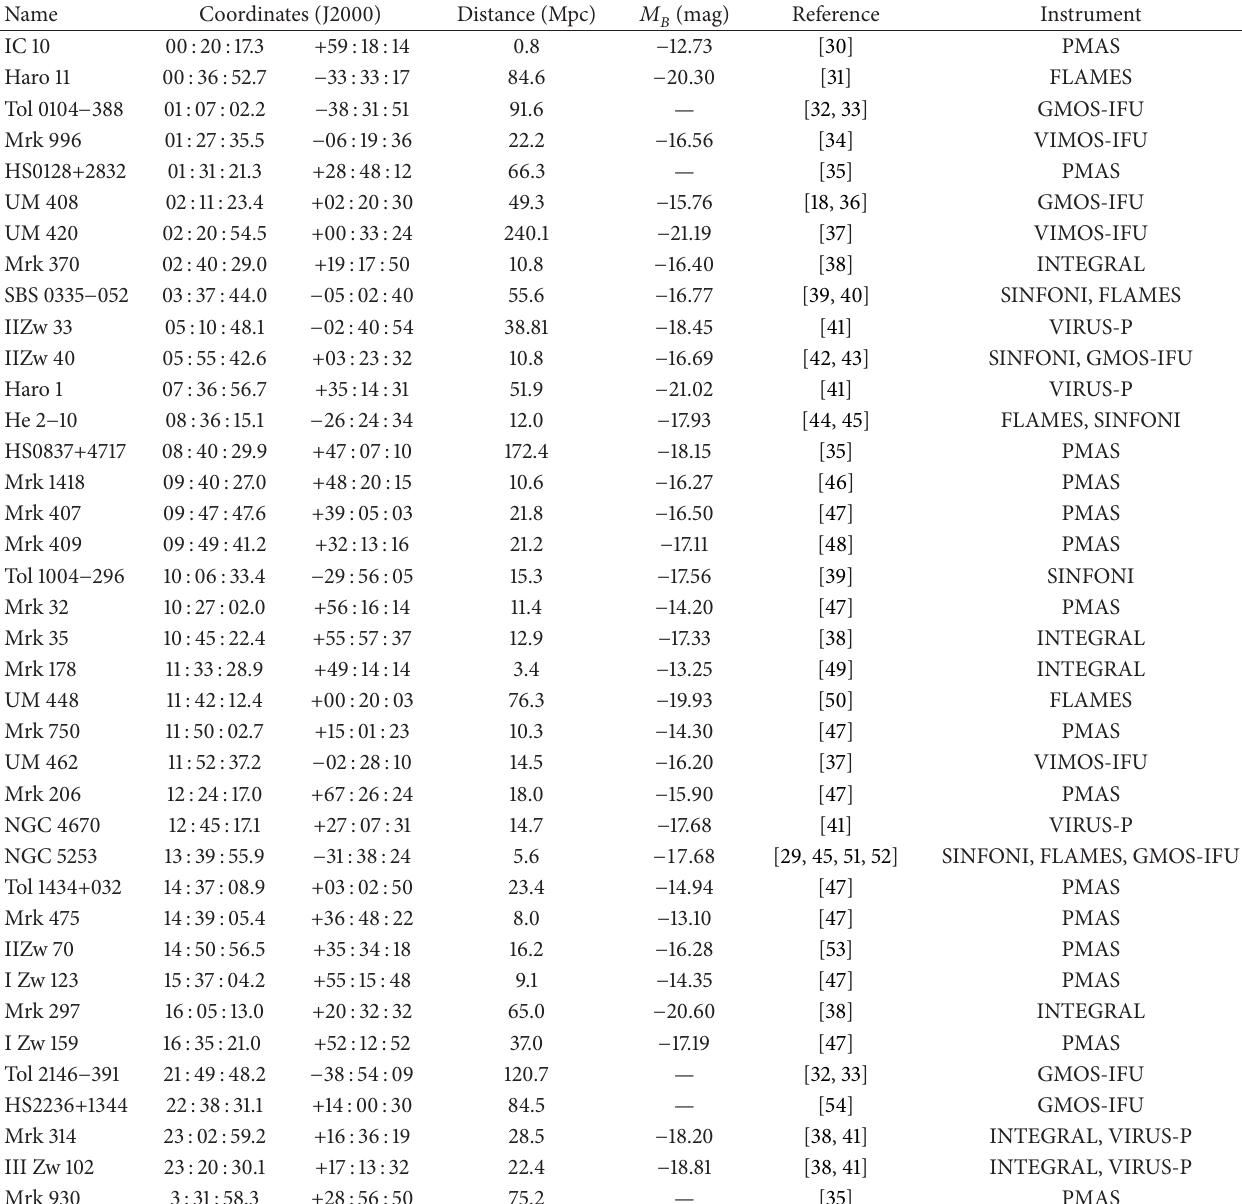
Table 1: H ii/BCD galaxies with published IFU observations. The list could be incomplete and does not include Fabry-Perot observations. Redshift distances obtained from NED assuming 𝐻 0 = 73 km s −1 Mpc −1 . 𝑀 𝐵 computed from the tabulated values of 𝑚 𝐵 obtained from